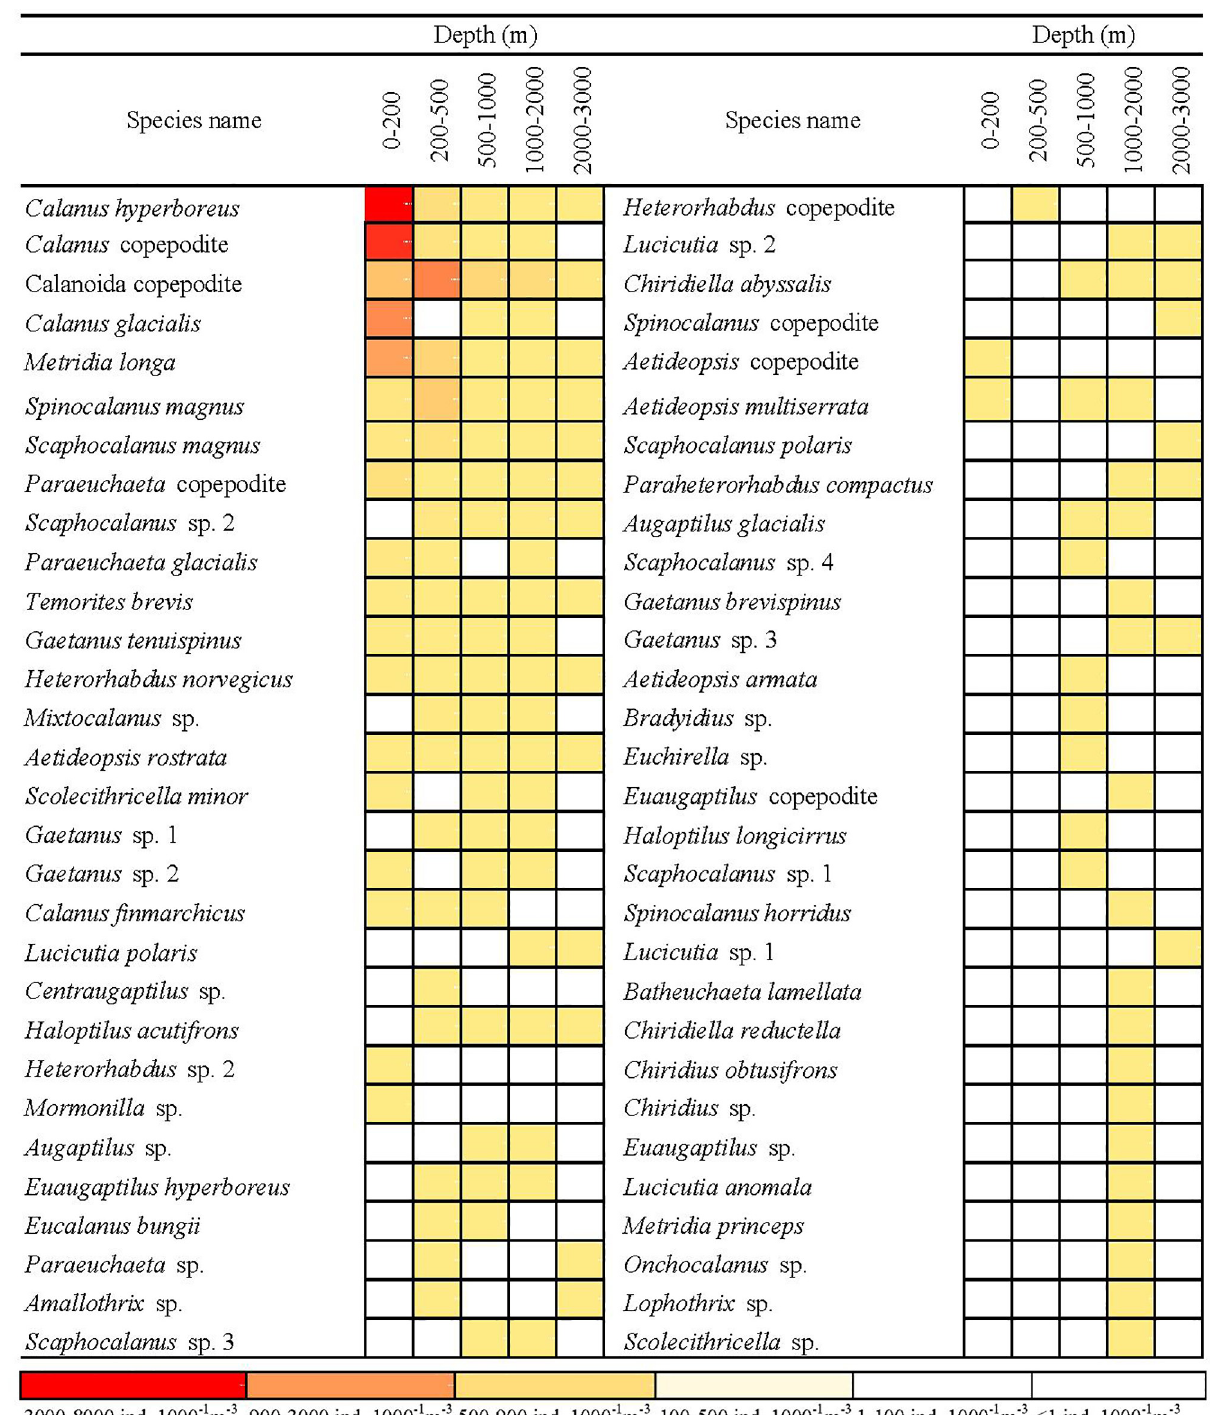
Fig 4. Abundance and distribution of each copepod species from five sampling